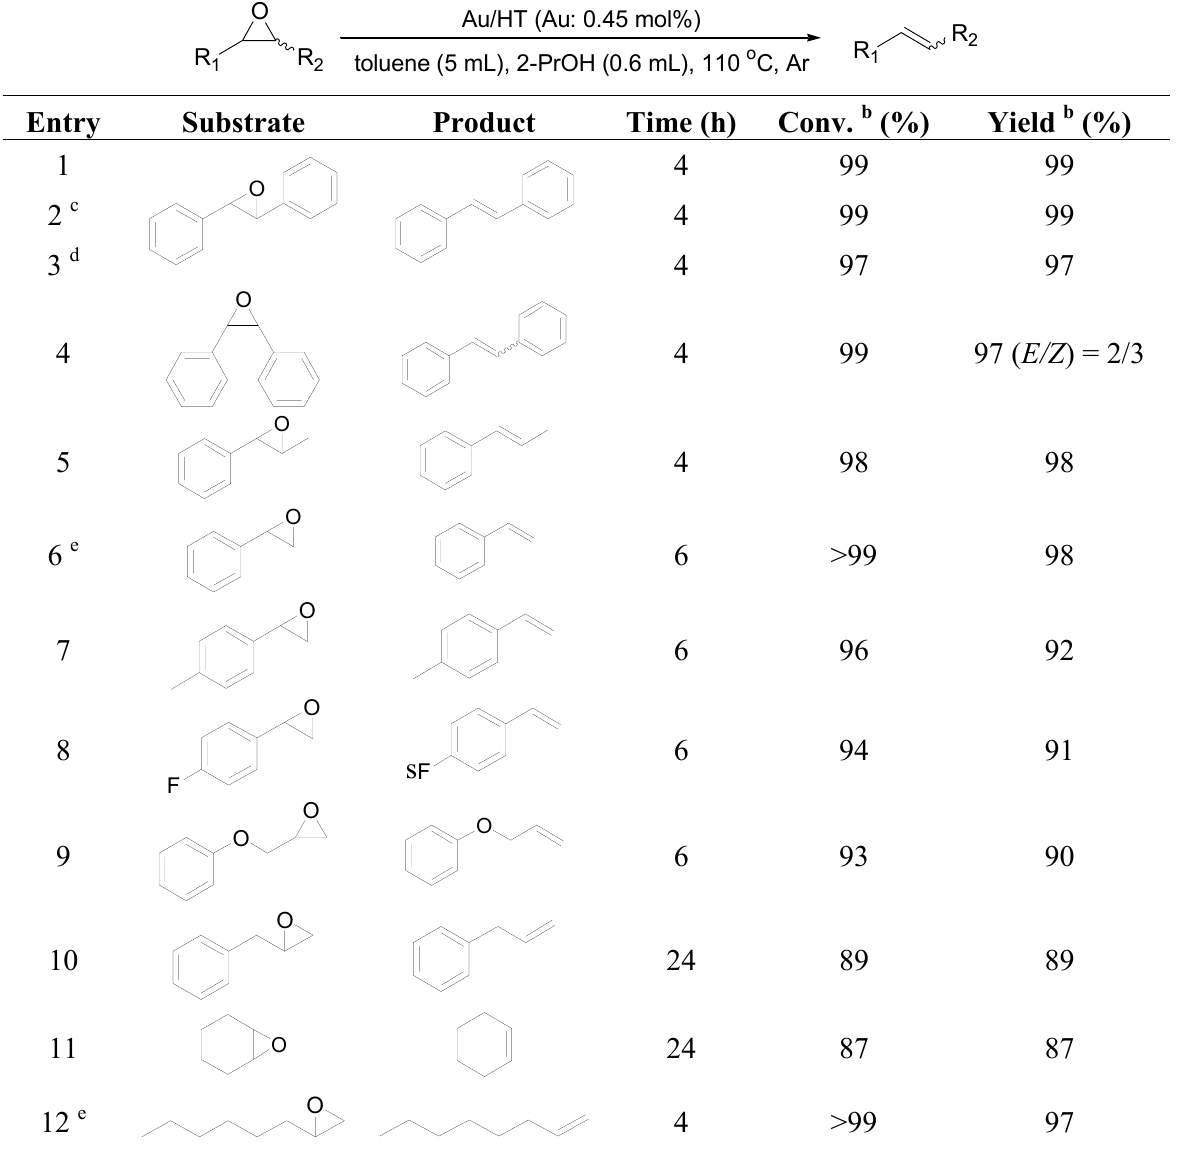
Table 2. Deoxygenation of various epoxides using Au/HT a